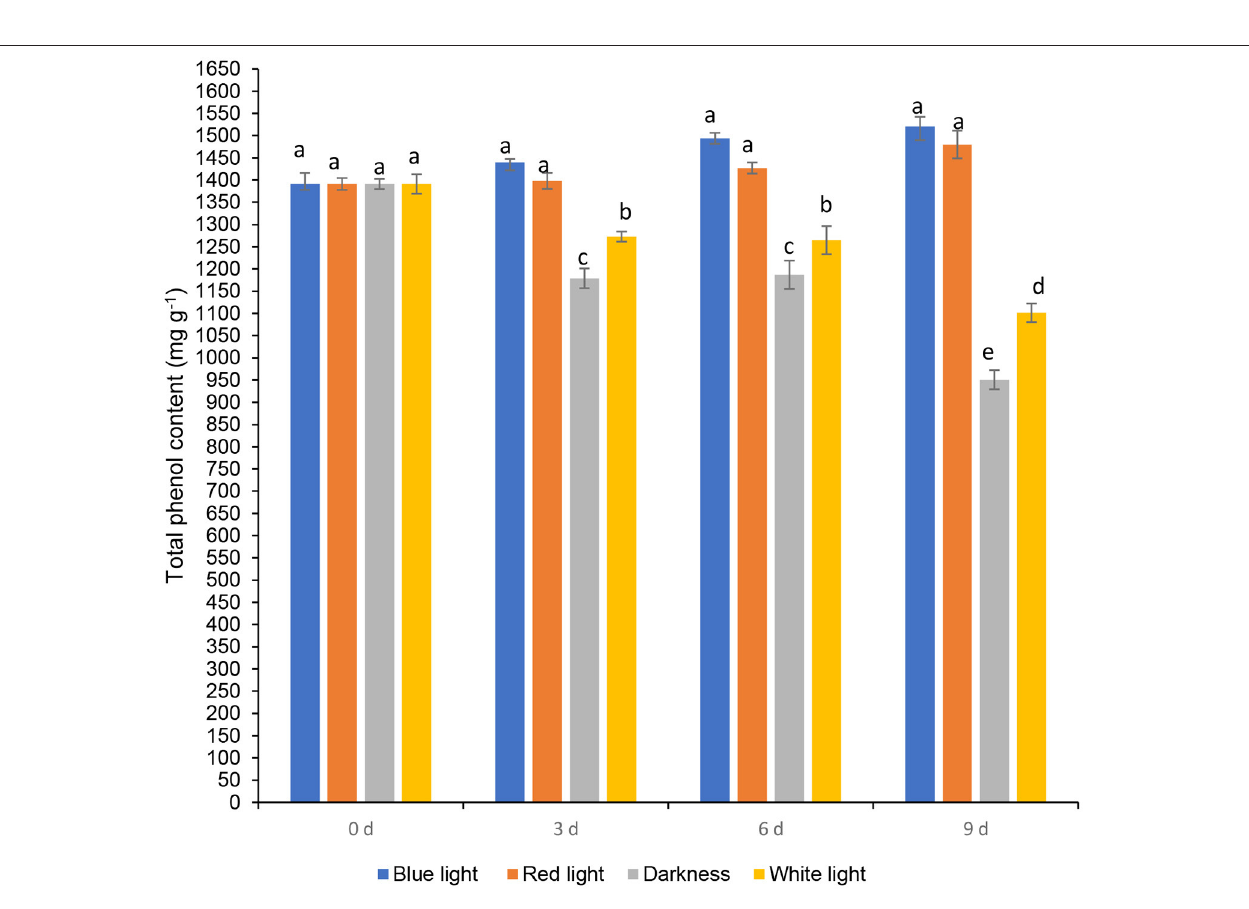
Frontiers in Nutrition |